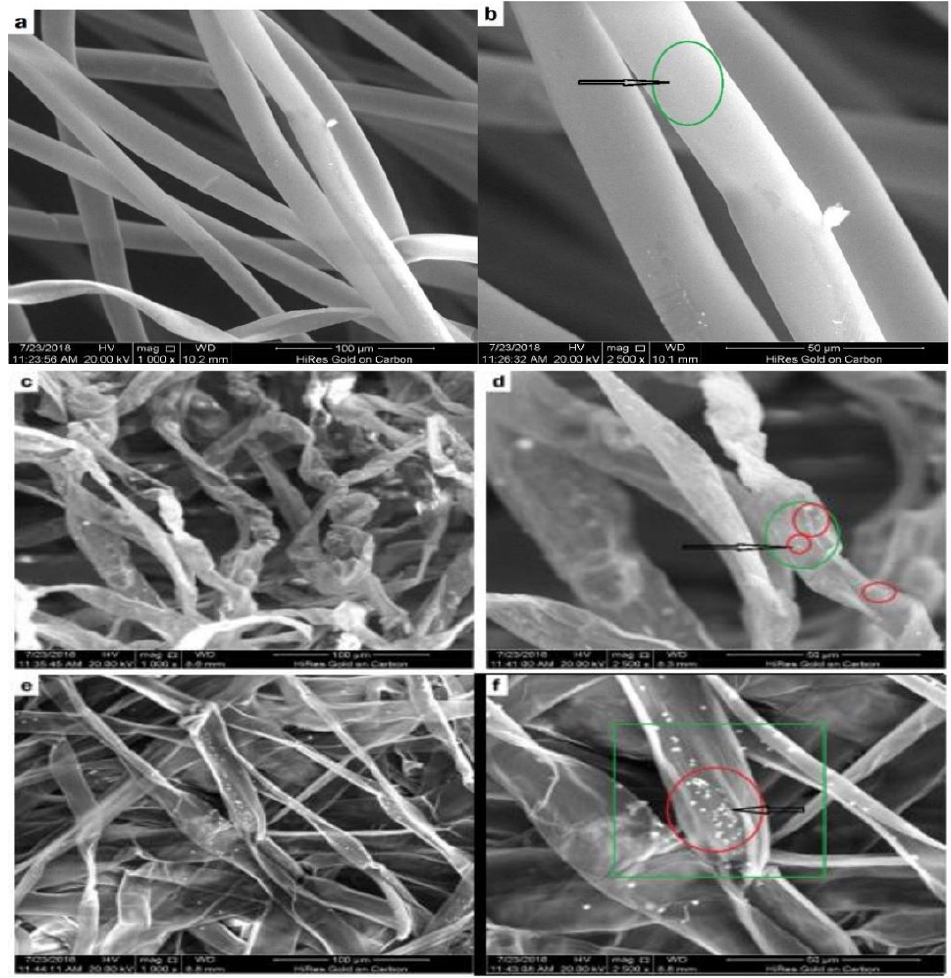
Figure 7. SEM images SEM Micrograph of ( a , b ) untreated kapok, ( c – f ) NaClO 2 -NaOH--treated kapok [84].